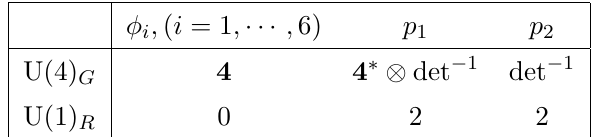
S (cid:3) (cid:10)O (1) (cid:8)O